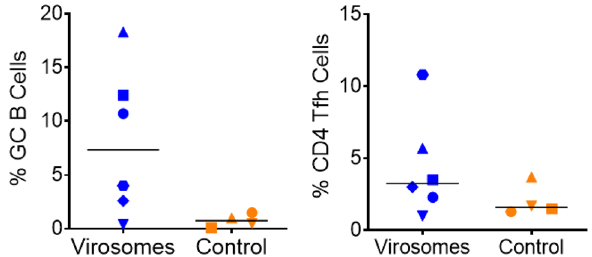
Figure 4. Immunization with Virosomes-RBD induces germinal center B cells in the spleen. The relative percentage of germinal center (GC) B cells over total B cells (left panel) and CD4 + T follicular helper cells (Tfh) over total CD4 + T cells (right panel) in the spleen is shown. Virosomes-RBD vaccinated (blue) and control animals (orange). Median values are indicated by horizontal black lines. Although we observed an increase in the percentage of GC B cells in the spleen at the day of necropsy in the virosomes-RBD group, it does not reach the 0.05 significance threhold ( p = 0.068), in part because the increase was observed for only 3 out of 6 animals. Tfh cells were not significantly different between the virosomes-RBD vaccine and the control group ( p =